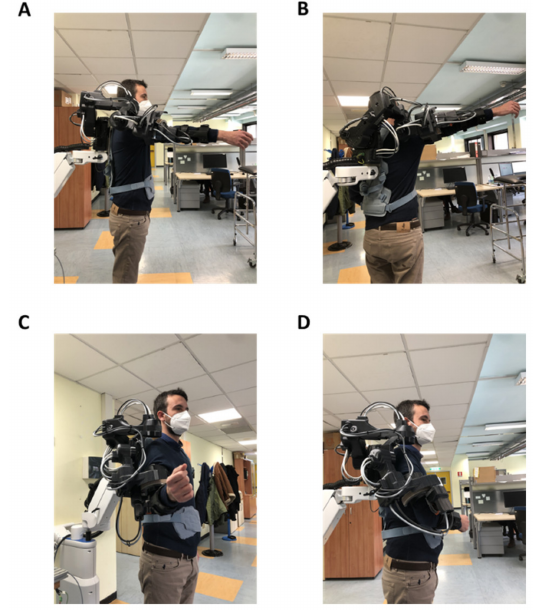
Figure 6. Kinematic mode on a healthy subject. ( A ) Represents a shoulder flexion. ( B ) Represents a shoulder abduction. ( C ) Represents an extra rotation. ( D ) Represents an intra